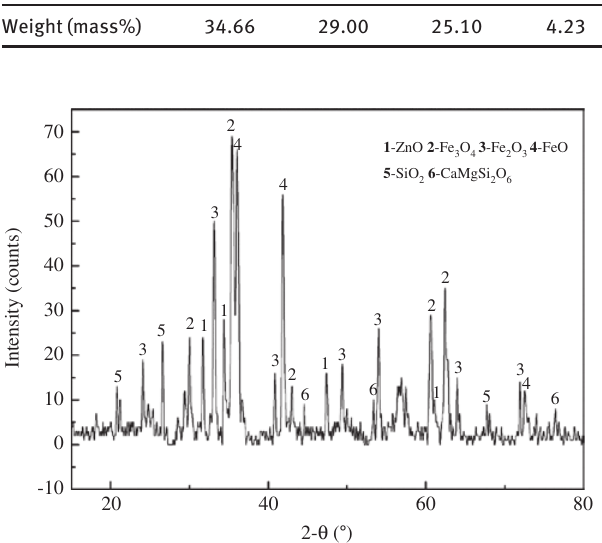
Figure 1: X-ray diffraction (XRD) pattern of the blast furnace dust.